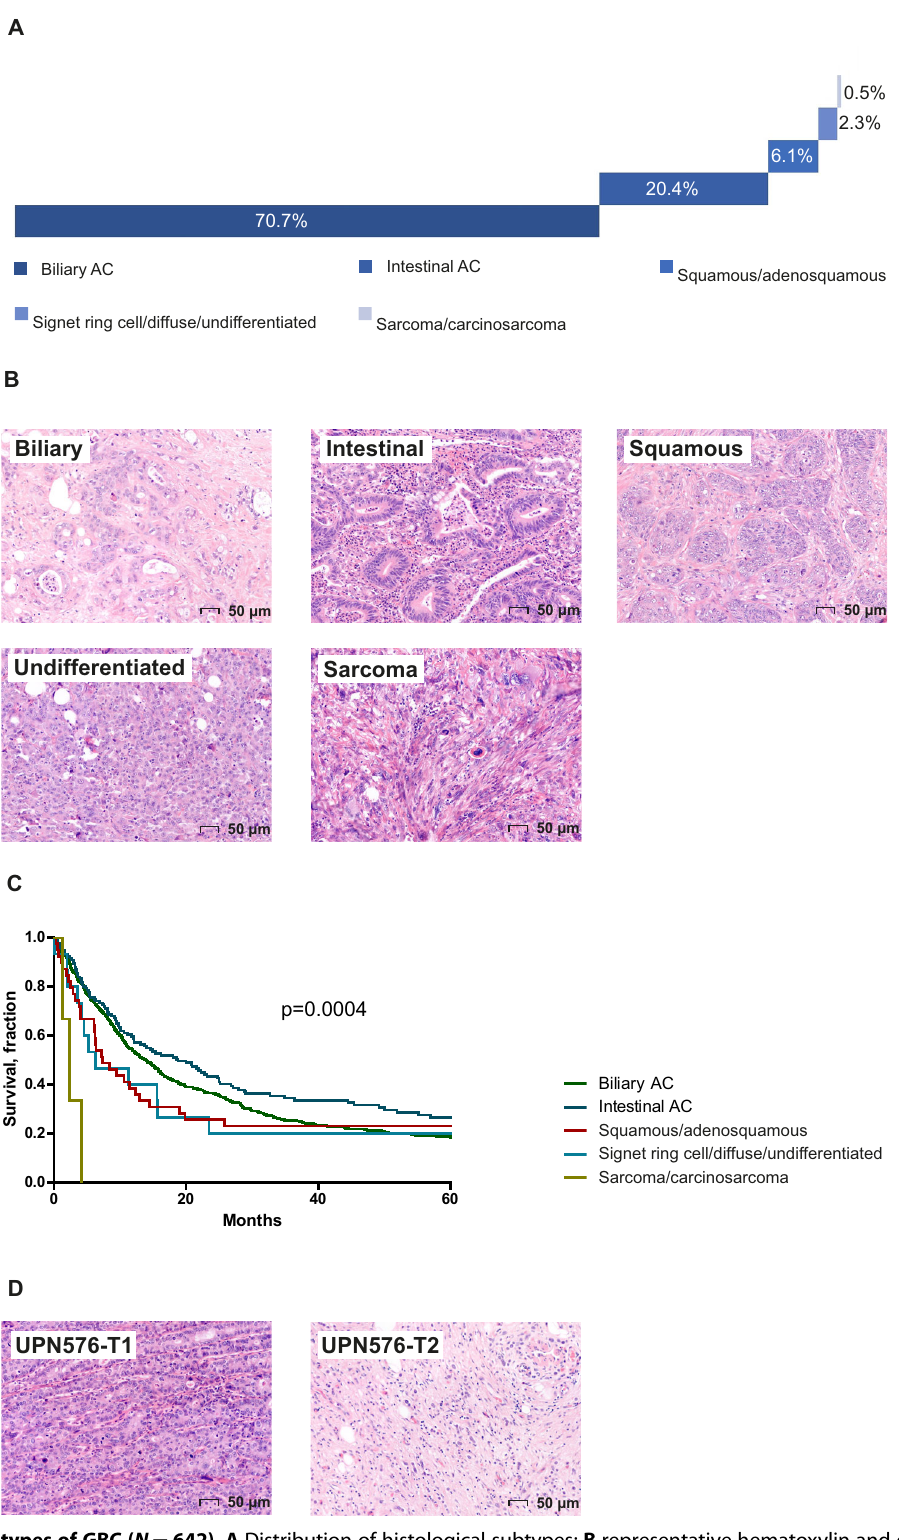
Fig. 2 Histological subtypes of GBC ( N = 642). A Distribution of histological subtypes; B representative hematoxylin and eosin stained slides of each subtype; C survival according to histological subtype; D two distinct morphological regions within the same tumor, with UPN576-T1 showing a predominantly solid undifferentiated growth pattern and UPN576-T2 showing a predominantly diffuse growth